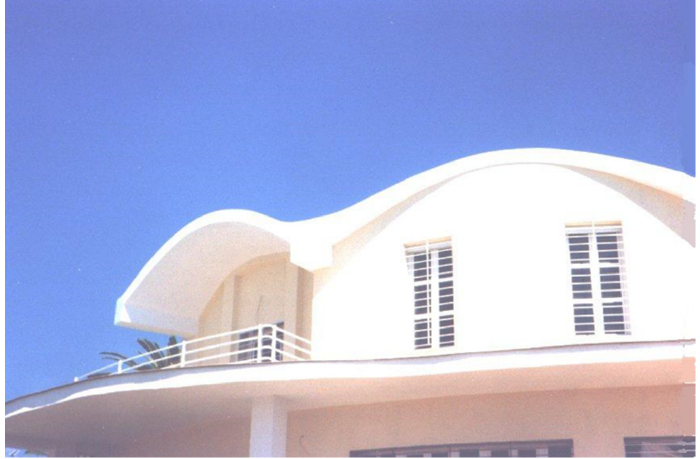
Figure 28. Detail of pseudo ‐ conoid roofs in which the sun ‐ path produces intriguing variations through the day.